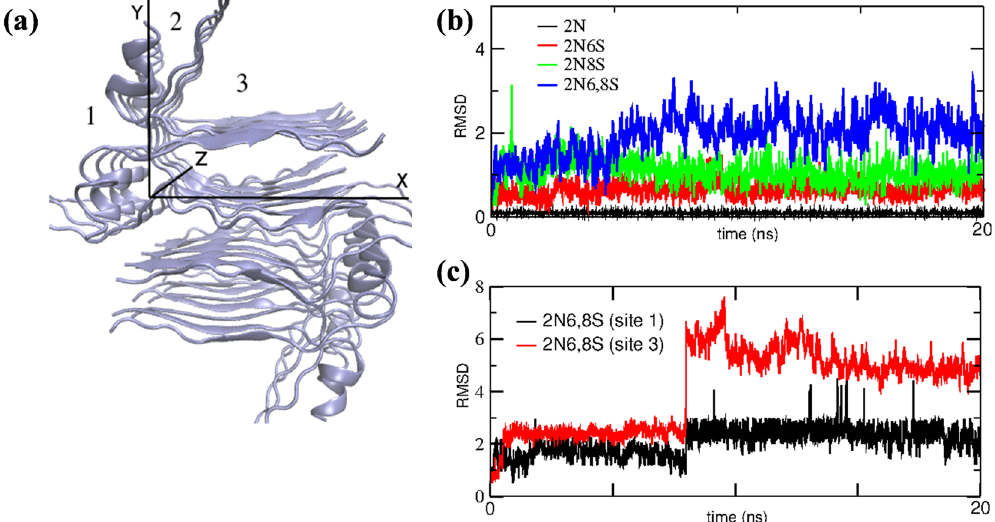
Figure 4. ( a ) The modelled structure of the insulin fibril. Essential axes shown include the 3D coordinate axes (X, Y, Z); the fibril axis is along the Z axis. ( b ) Positional fluctuations of each photoacid as a function of time in binding site 2 and ( c ) of 2N6,8S in binding sites 1 and 3. The large ‘jump’ in the trace for 2N6,8S after ~7.5 ns in binding site 3 is due to changes in the binding mode of 2N6,8S to the protein surface in this binding site (see structures and discussion in Figures